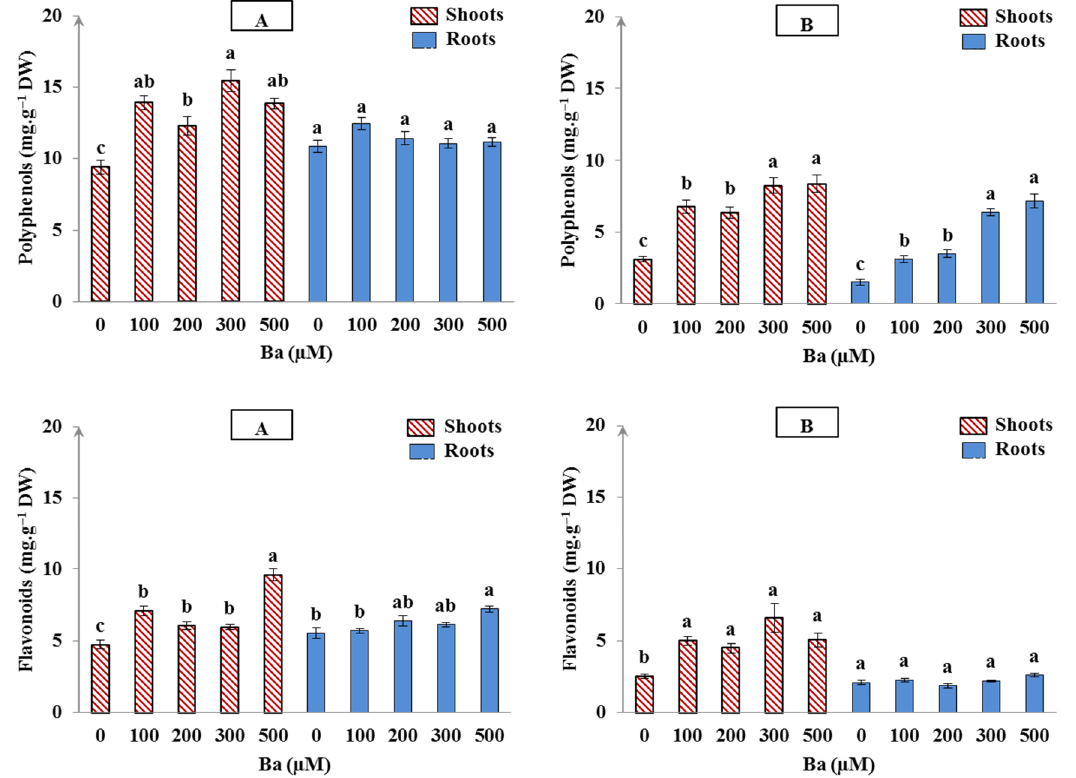
Figure 4. Accumulation of polyphenols and flavonoids in shoots and roots of Limbarda crithmoides ( A ) and Helianthus annuus ( B ) plants after 45 days of Ba treatments. Data are presented in mean values ± SD, n = 10. Bars marked with different lower-case letters were significantly different at p < 0.05.